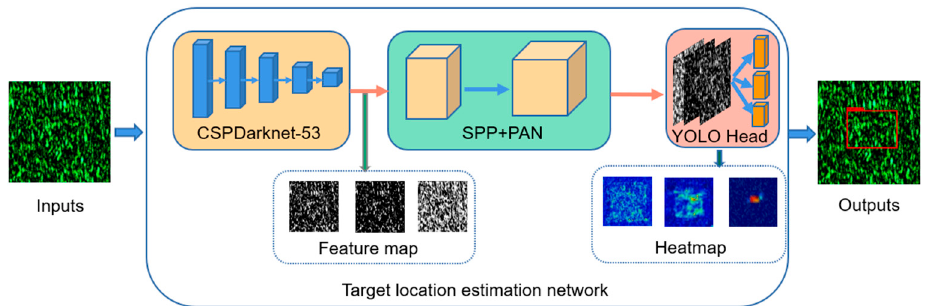
Figure 4. Efficient position estimation method for unknown hidden targets based on data-decoupled opaque scattering media. The input is the scattered image, and the output is the target-position detection box. In the outputs image, the red box represents the target position result.